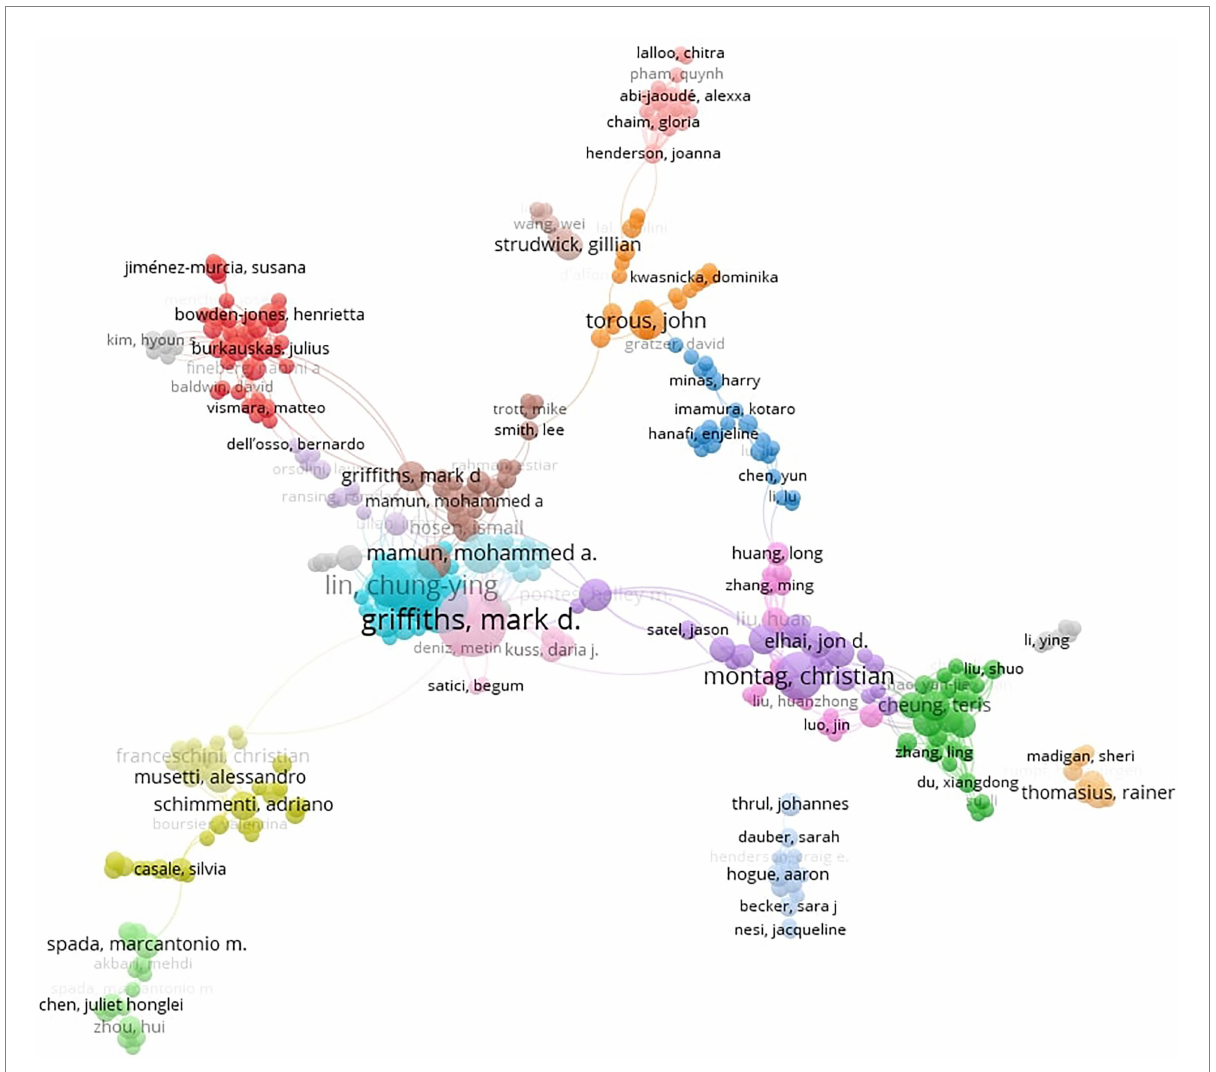
FIGURE 1 Co-authorship covering the